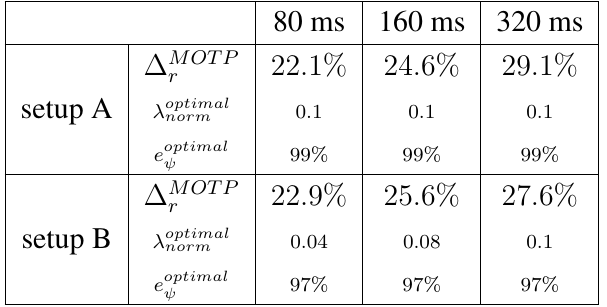
Table 4. Relative improvements of MOT P ( m ) for sequence seq01 , including the values of the optimal parameters, estimated per microphone setup and per frame size.